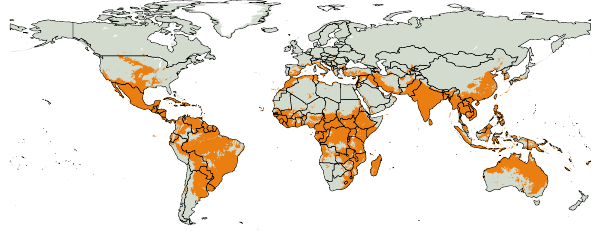
Figure 6. Global map indicating the areas (in orange) prone to infil- tration excess surface runoff, defined as those areas where extreme precipitation exceeds the infiltration rate (Fig. S2). See the Supple- ment for more